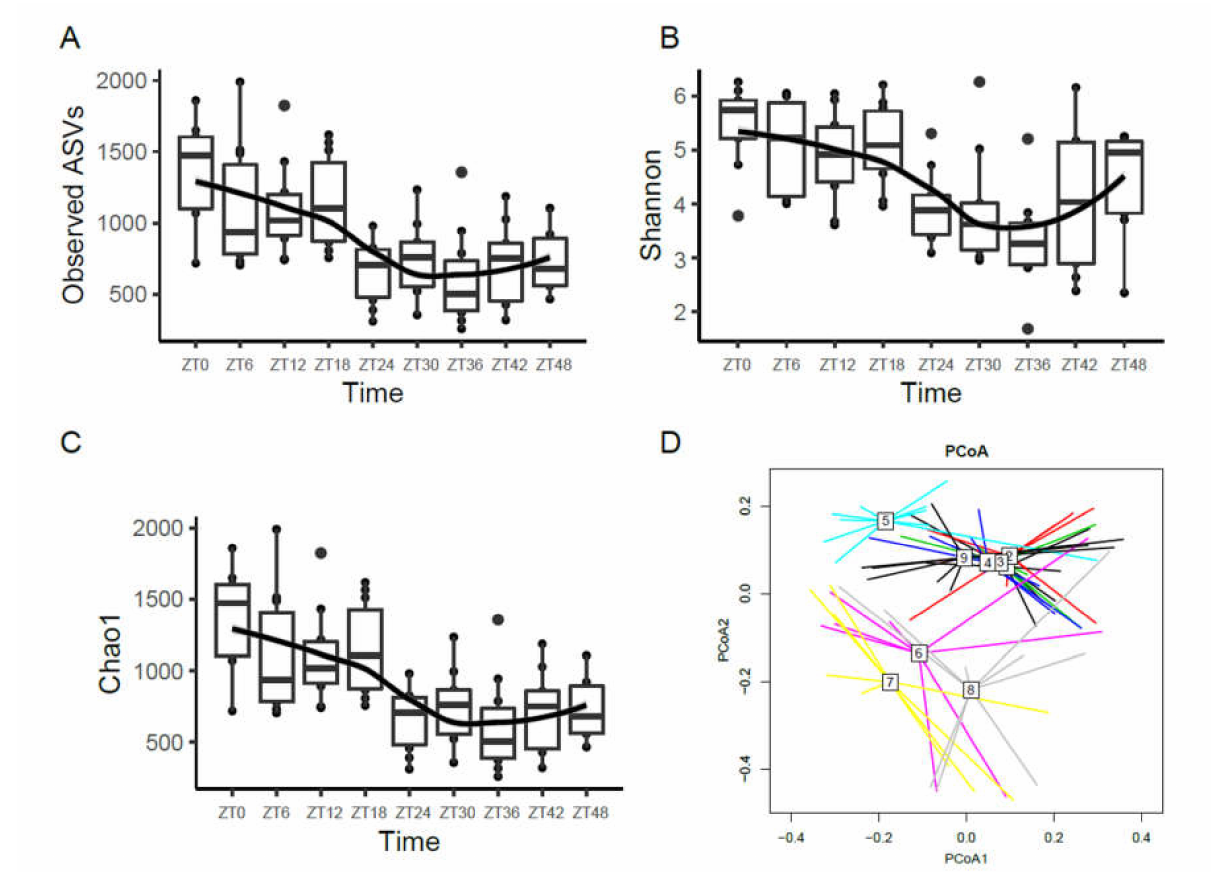
Figure 1. Changes in fecal microbiota diversity. ( A ) Bacterial alpha diversity determined by the Observed ASVs; ( B ) Bacterial alpha diversity determined by the Chao1 index; ( C ) Bacterial alpha diversity determined by the Shannon index; ( D ) PCoA of the fecal microbiota at each time point. The Black line represents the fitted trend